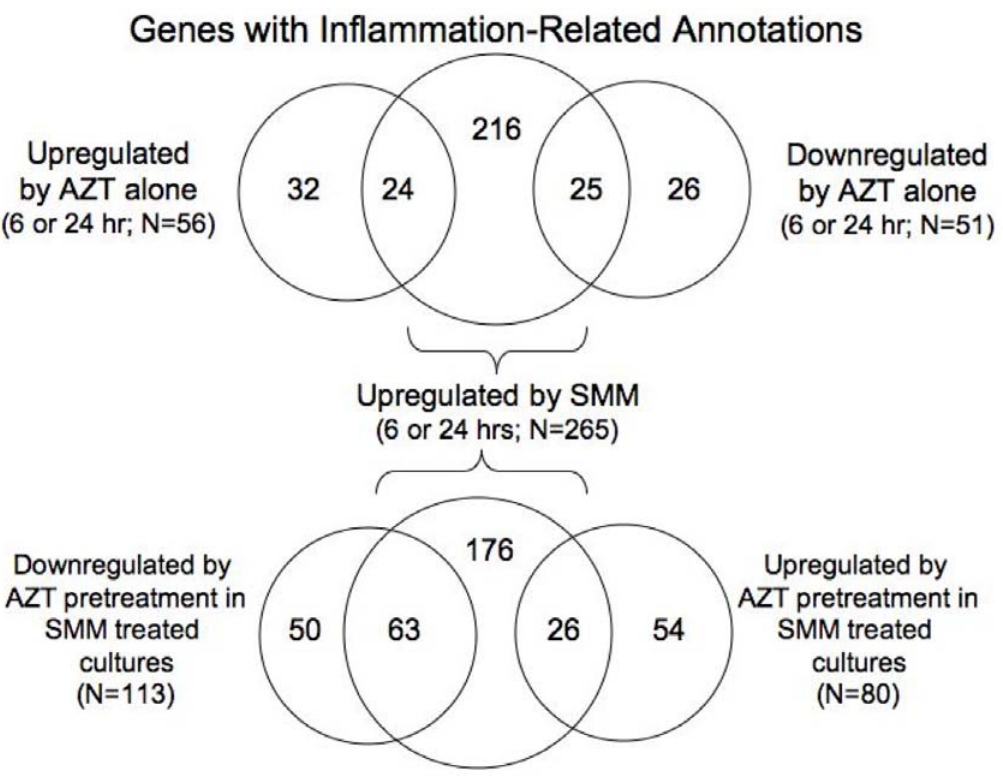
Figure 3. Venn diagrams representing the number of differentially expressed inflammation-related genes as a function of treatment. The top Venn diagram compares SMM-induced genes to AZT up- and down-regulated genes. The bottom Venn diagram shows how AZT pretreatment affected SMM genes.